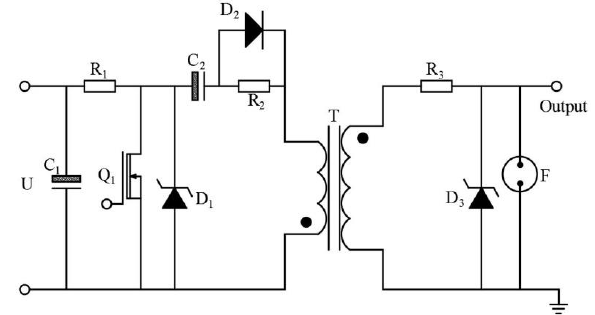
Figure 10. Interference suppression circuit.